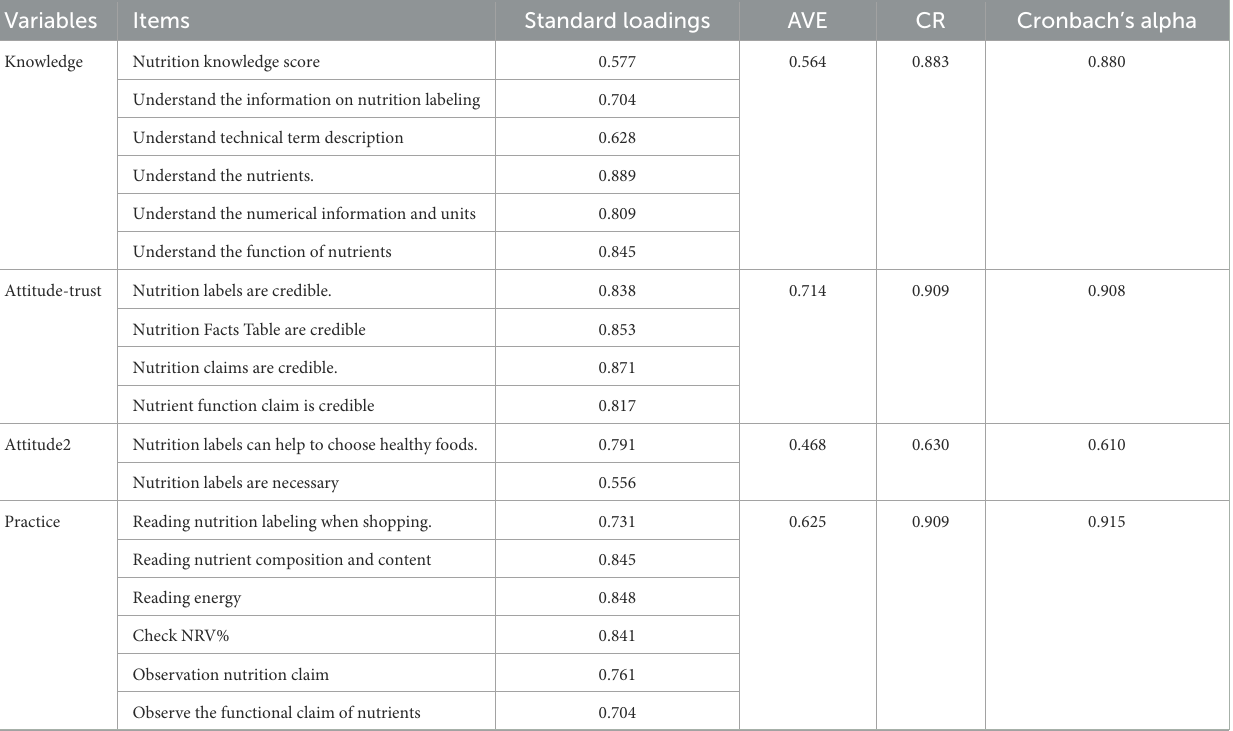
TABLE 6 Factor loadings and convergent validity results.